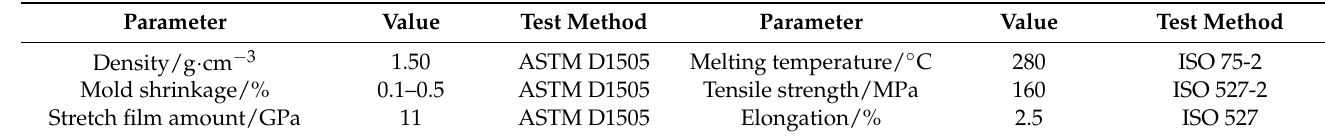
Table 5. Physical parameters of PPS.